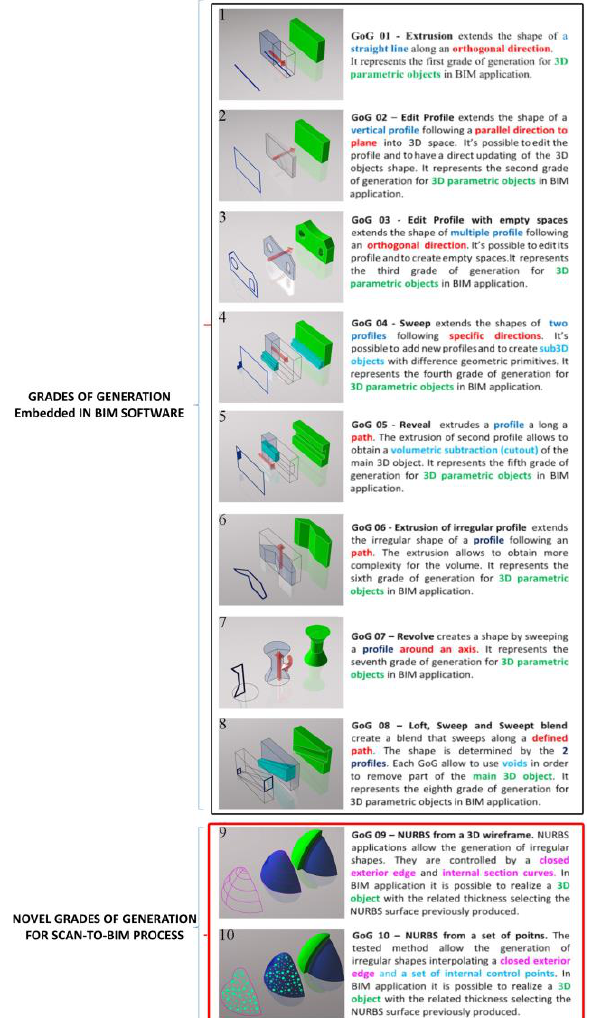
Figure 2. The novel scan-to-BIM modeling requirements in Banfi, F. (2017). BIM orientation: grades of generation and information for the different type of analysis and management